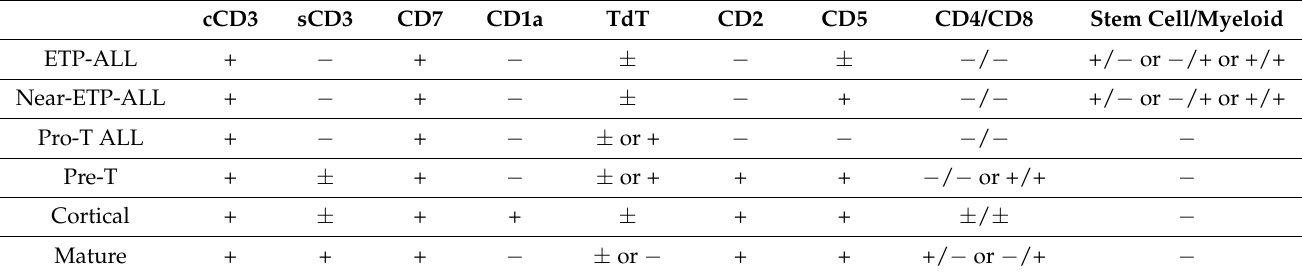
Table 2. Immunophenotypic features of T-ALL at different stages of